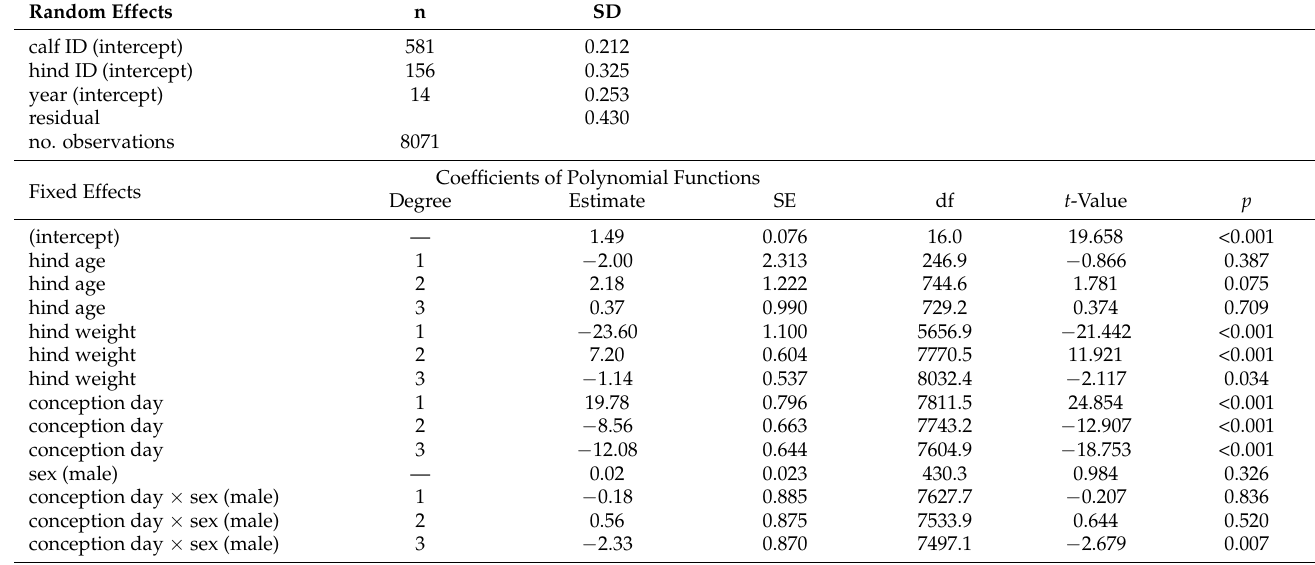
Table 5. Coefficients and statistics of a polynomial mixed model to assess hypothesis H5 (in Table 1) on pelt biting. Female is the sex of reference. Other acronyms as in Table